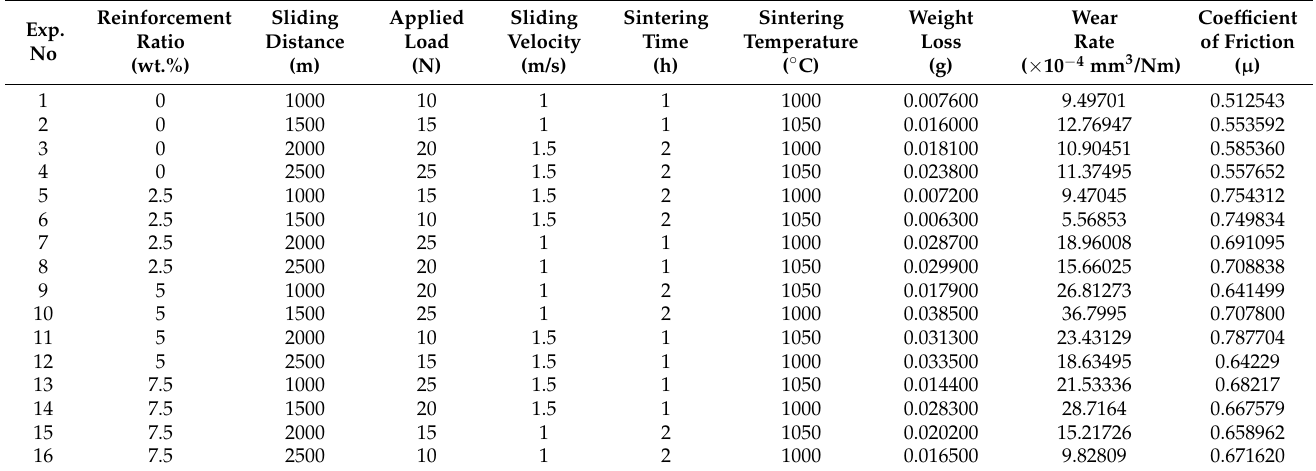
Table 2. Design parameters and related experimental results after the tribological tests.